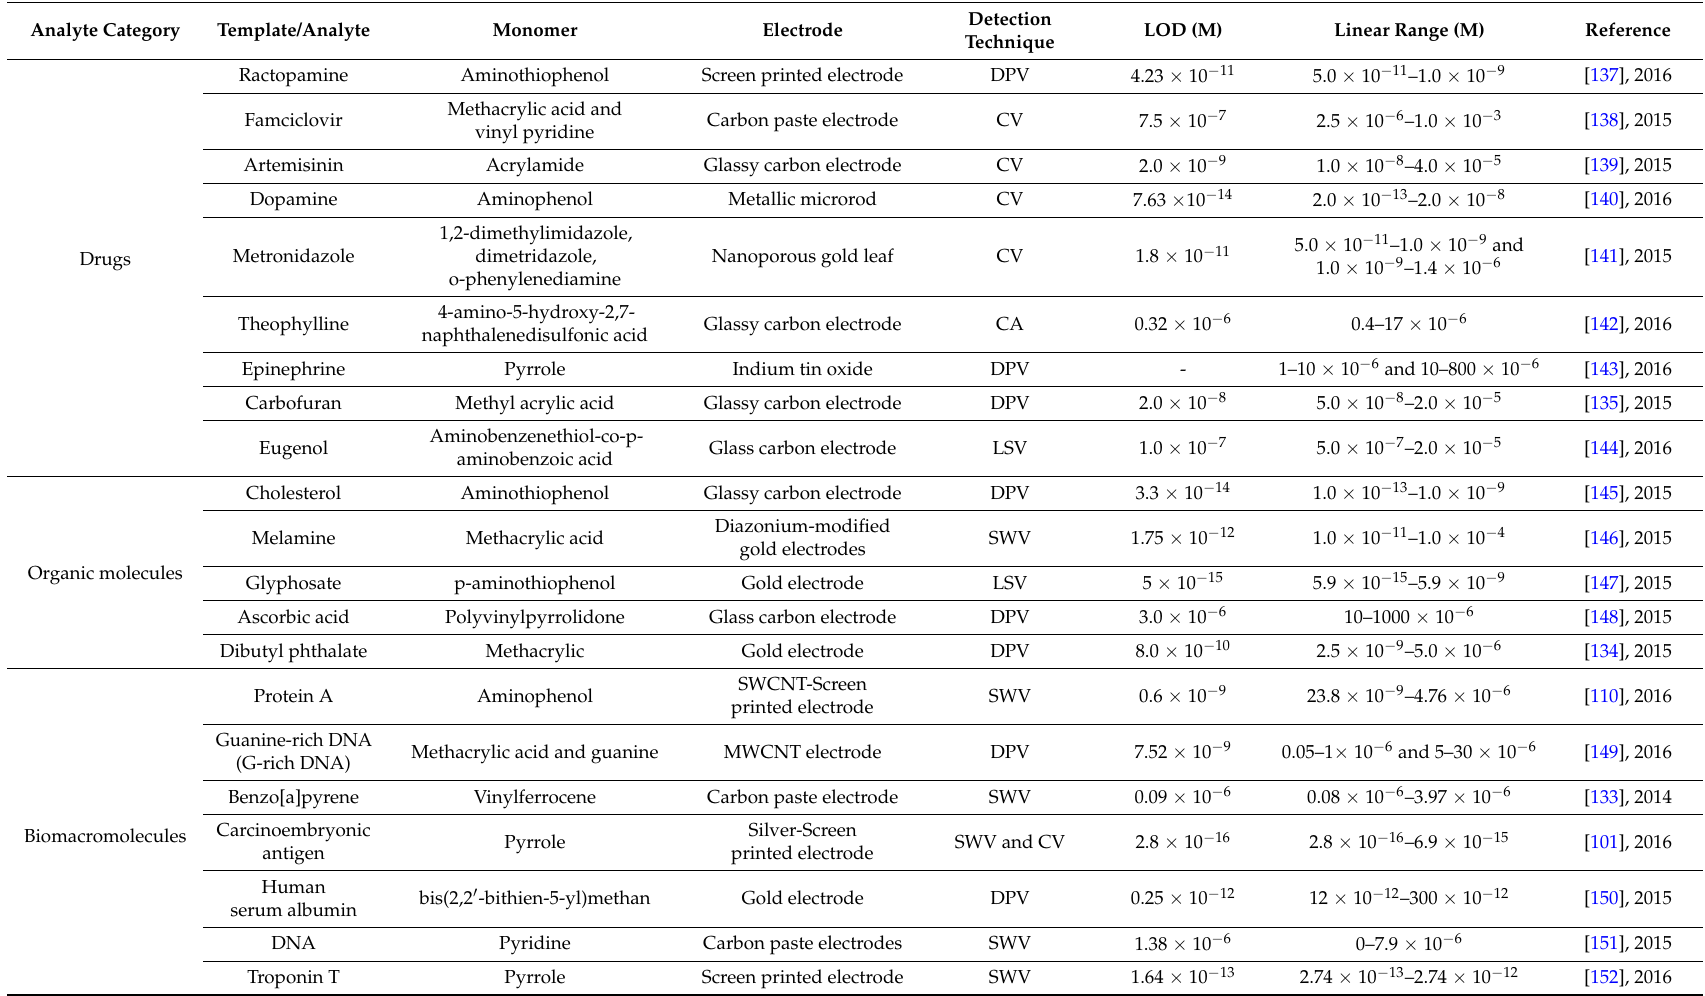
Table 1. Voltammetric transduction for MIP based electrochemical sensors